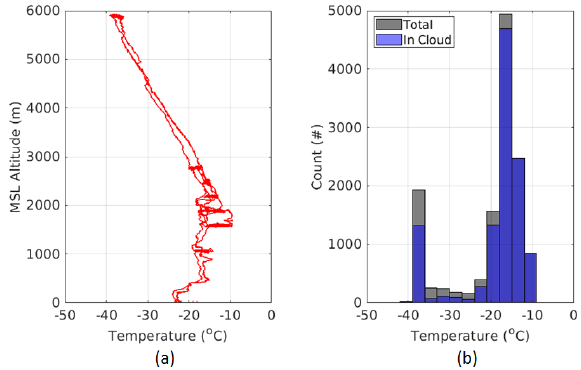
Figure 7. (a) Temperature as a function of altitude for the 22 November flight. (b) Histogram of the in situ temperature shows that for most of the flight the in-cloud temperature was at around − 15 ◦